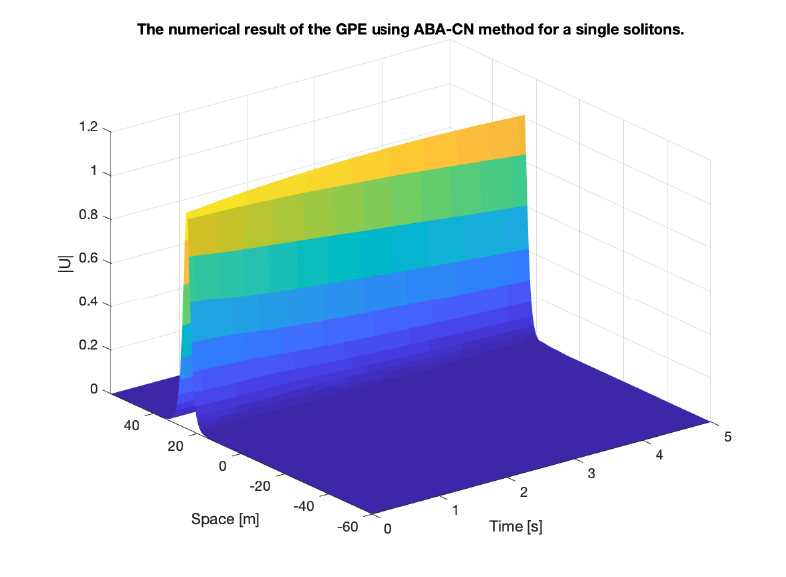
Figure 2. Numerical solution with the ABA-CN method of the single